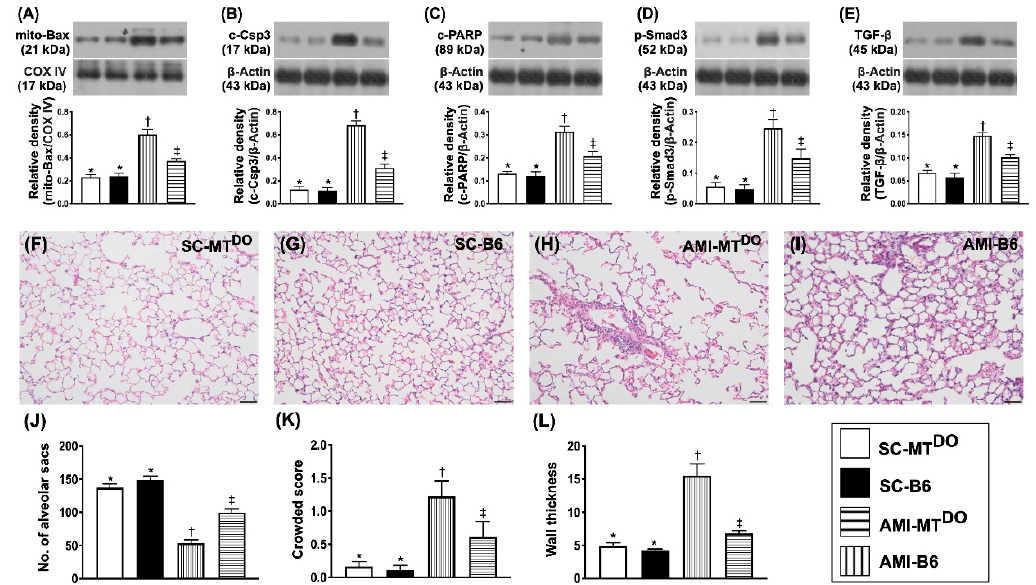
Figure 3. Protein expressions of apoptosis and fibrosis in LV myocardium by 60 days after the AMI procedure. ( A ) Protein expressions of mitochondrial (mito)-Bax, * vs. other groups with different symbols (†, ‡), p < 0.0001. ( B ) Protein expression of cleaved caspase 3 (c-Csp3), * vs. other groups with di ff erent symbols (†, ‡), p < 0.0001. ( C ) Protein expression of cleaved poly (ADP-ribose) polymerase (c-PARP), * vs. other groups with different symbols (†, ‡), p < 0.0001. ( D ) Protein expression of phosphorylated (p)-Smad3, * vs. other groups with different symbols (†, ‡), p < 0.0001. ( E ) Protein expression of transforming growth factor (TGF)-ß, * vs. other groups with different symbols (†, ‡), p